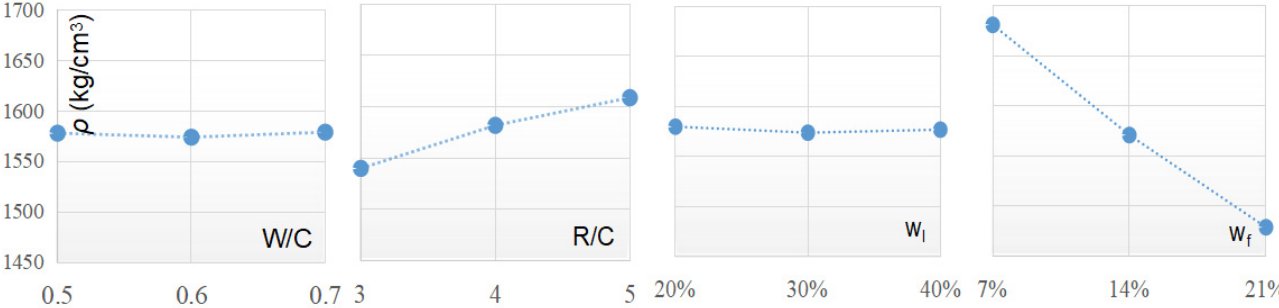
Figure 9. Intuitive analysis of the softening coefficient of four factors.